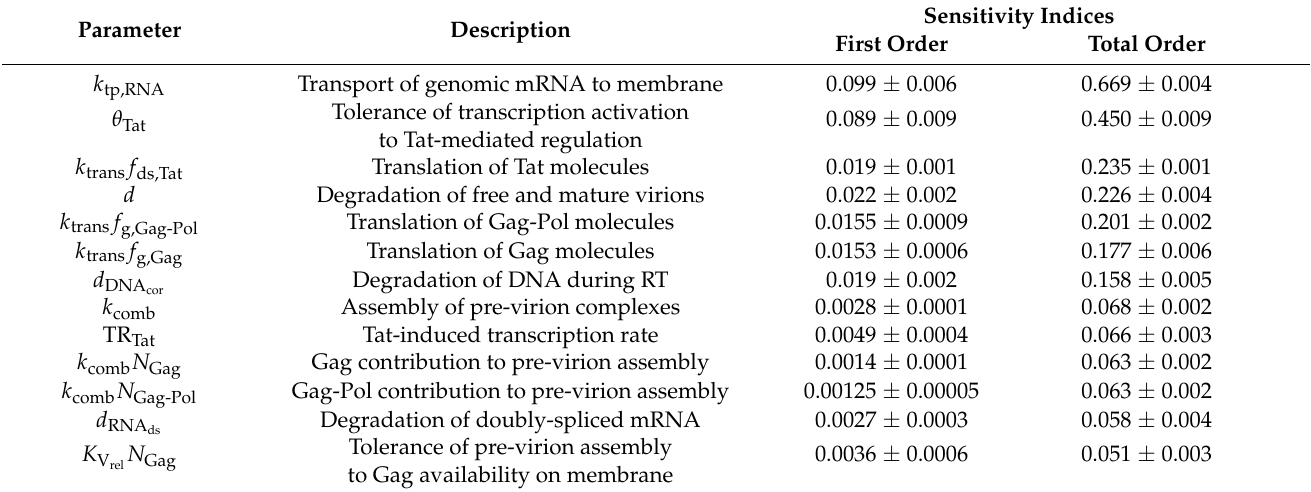
Table 2. Sensitivity indices of the model parameters that have the biggest influence on cumulative virion release. The param- eters are sorted in descending order by total order sensitivity indices. The means ± SEMs obtained on N r = 20 resamples are